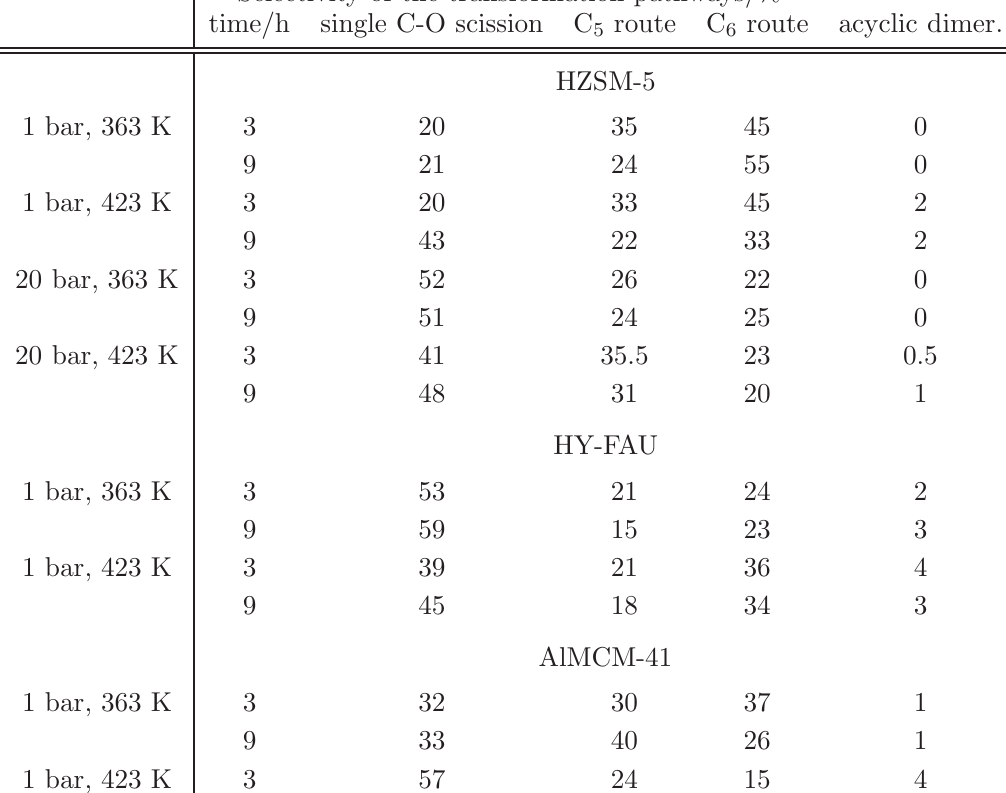
Table 3 Proportions of the reaction channels in the transformations of methyloxirane ( 1 ) over various molecular sieves (catalyst 100 mg, starting mixture: 2 cm 3 of 1 and 2 cm 3 of CH 2 Cl 2